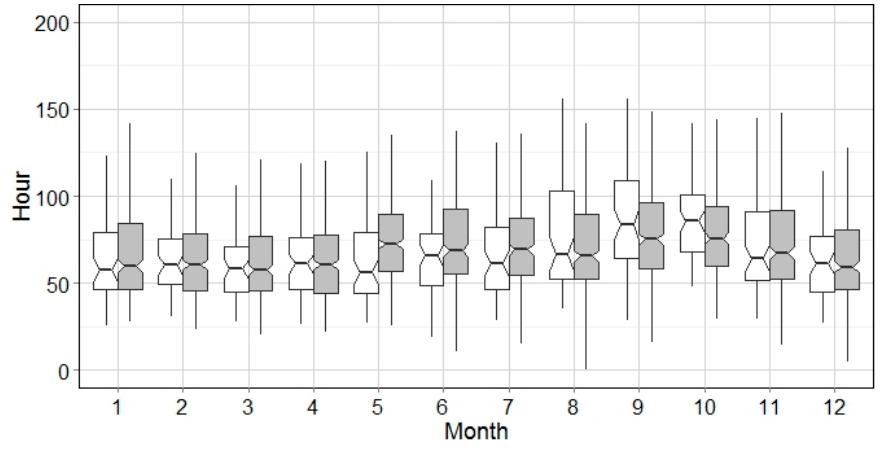
Figure 7. Boxplots of DED SDs (Historical: White, Synthetic: Grey).